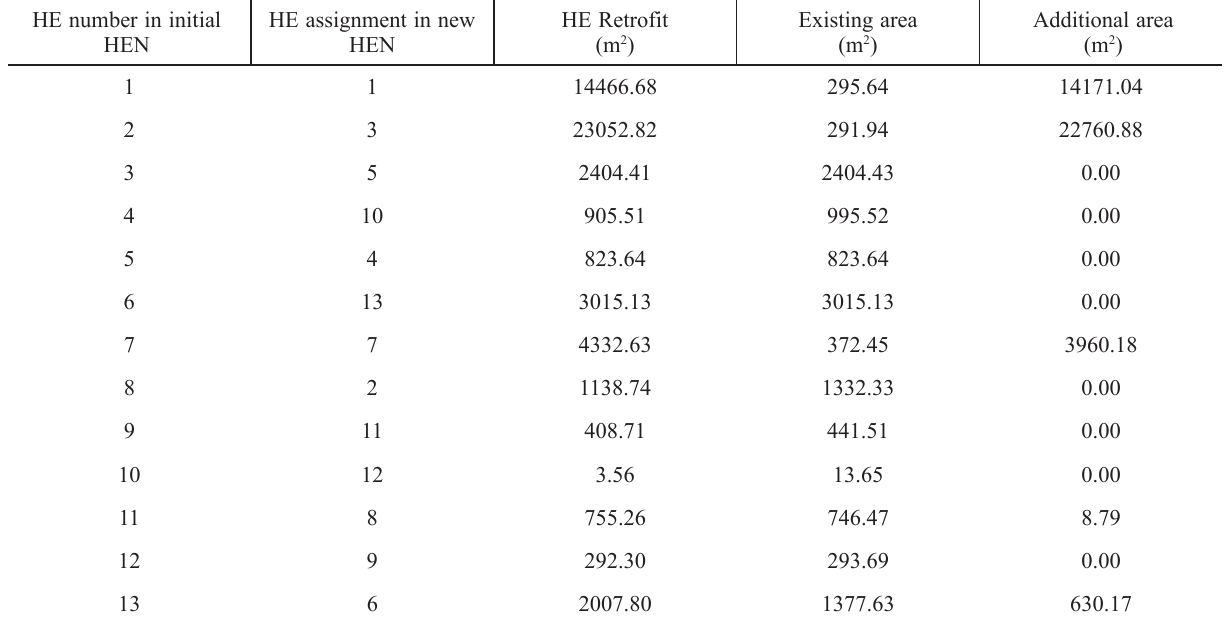
Table 9 – Reassignment of HEs and area distribution in case study two for the optimal HEN HE number in initial HE assignment in new HEN HEN